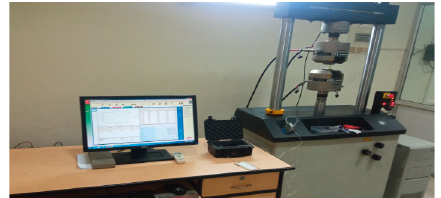
Figure 4: Tensile testing with Instron 5980 series.